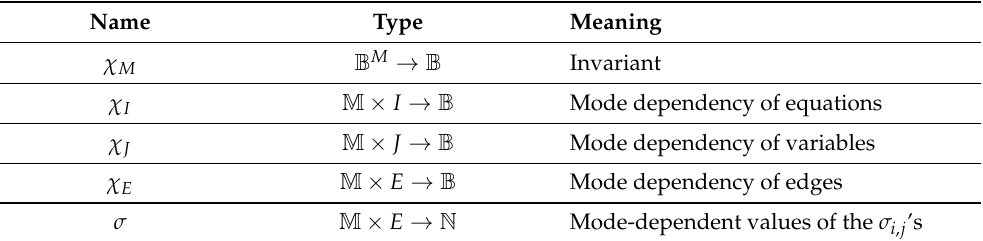
Table 1. Functions generated from parsing the